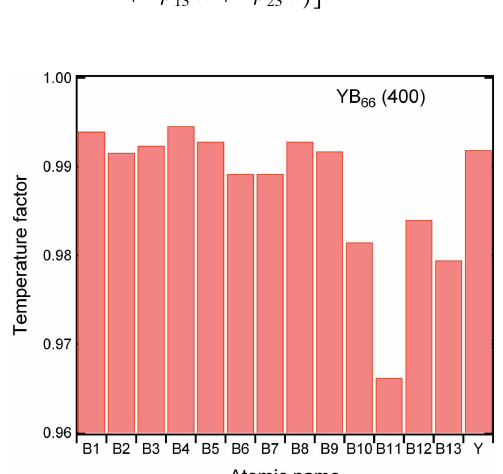
Figure 2 Anisotropic temperature factor of 14 symmetric sites for YB 66 (400), each site labeled with atomic name and site index. The temperature factors vary on symmetric sites for 13 boron atoms, except B6 and B7 for which they are the